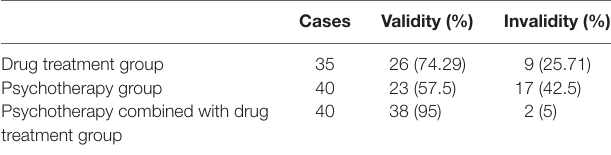
TaBle 5 | Effects of 12 weeks of treatment in each